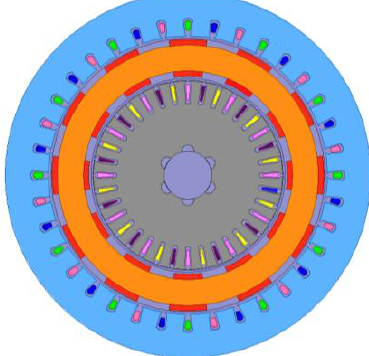
Figure 11. The FEM model of the CSPM motor.